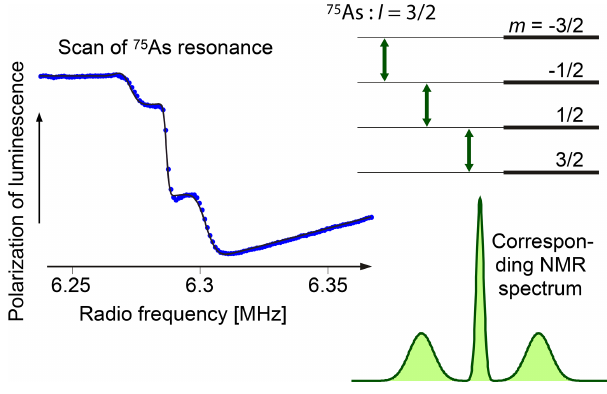
Figure 28. CW NMR spectrum measured by scanning the RF in a constant field of